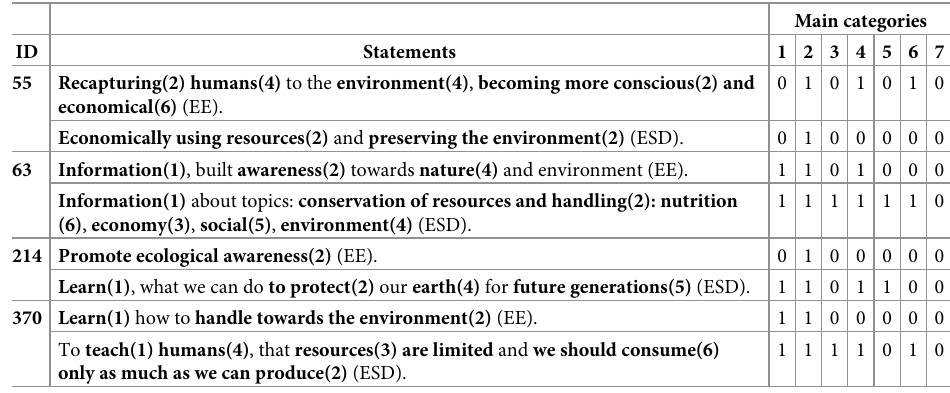
Table 1. Categorization examples from freshmen between EE and ESD.